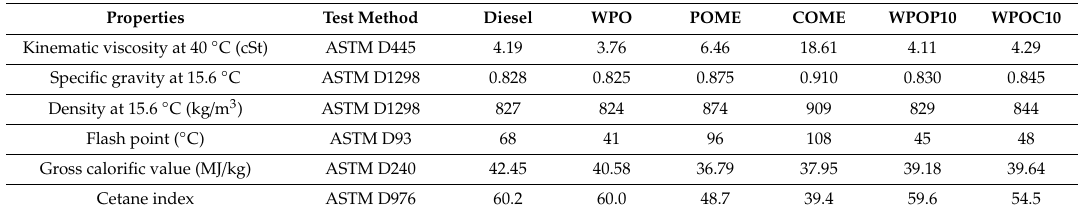
Table 3. Properties of the test fuels.